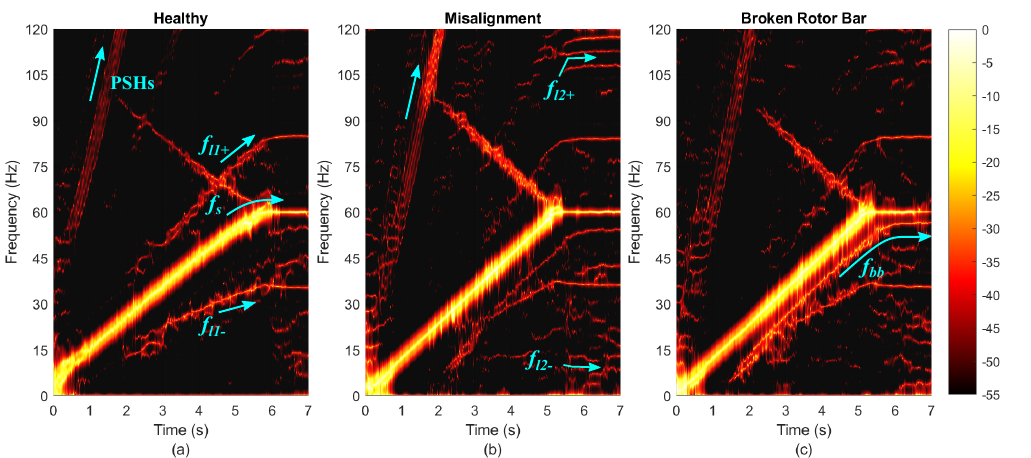
Figure 5. Min-Norm ( t , f ) analysis of the starting current with the adjustable speed drive (ASD) induction motor driving a rated load, for the case of: ( a ) Healthy motor. ( b ) Mechanical misalignment. ( c ) Motor with one broken rotor